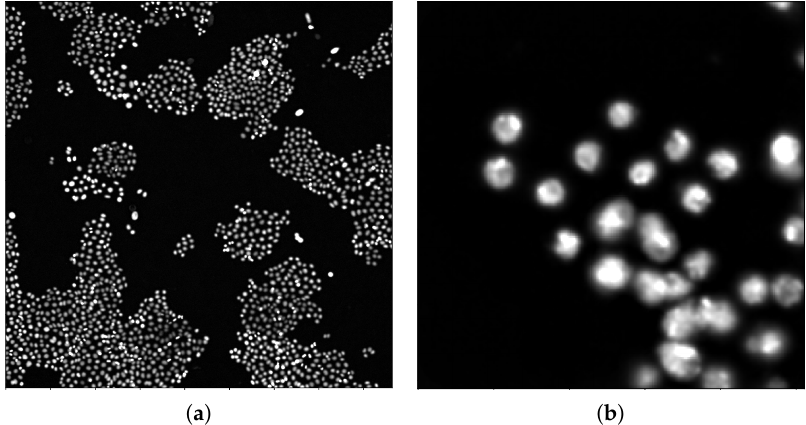
Figure 5. Result of the application of the pre-processing steps on the images shown in Figure 1b ( a ) and Figure 2a ( b